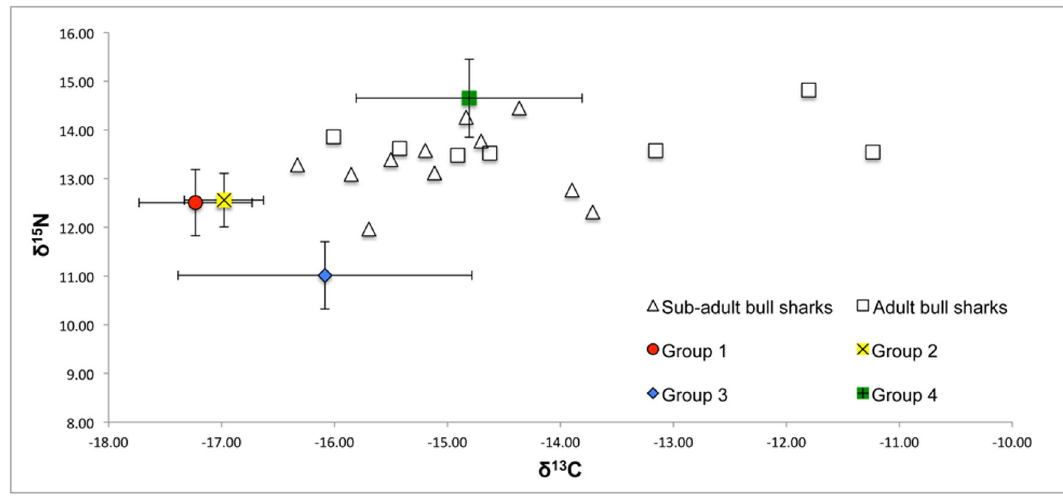
Figure 2. A dual isotope plot representing the sampled fish community and individual bull sharks. Fish groups represented by the mean δ 13 C and δ 15 N values (±SD). Adult individual bull sharks are represented by squares and sub-adults are represented by